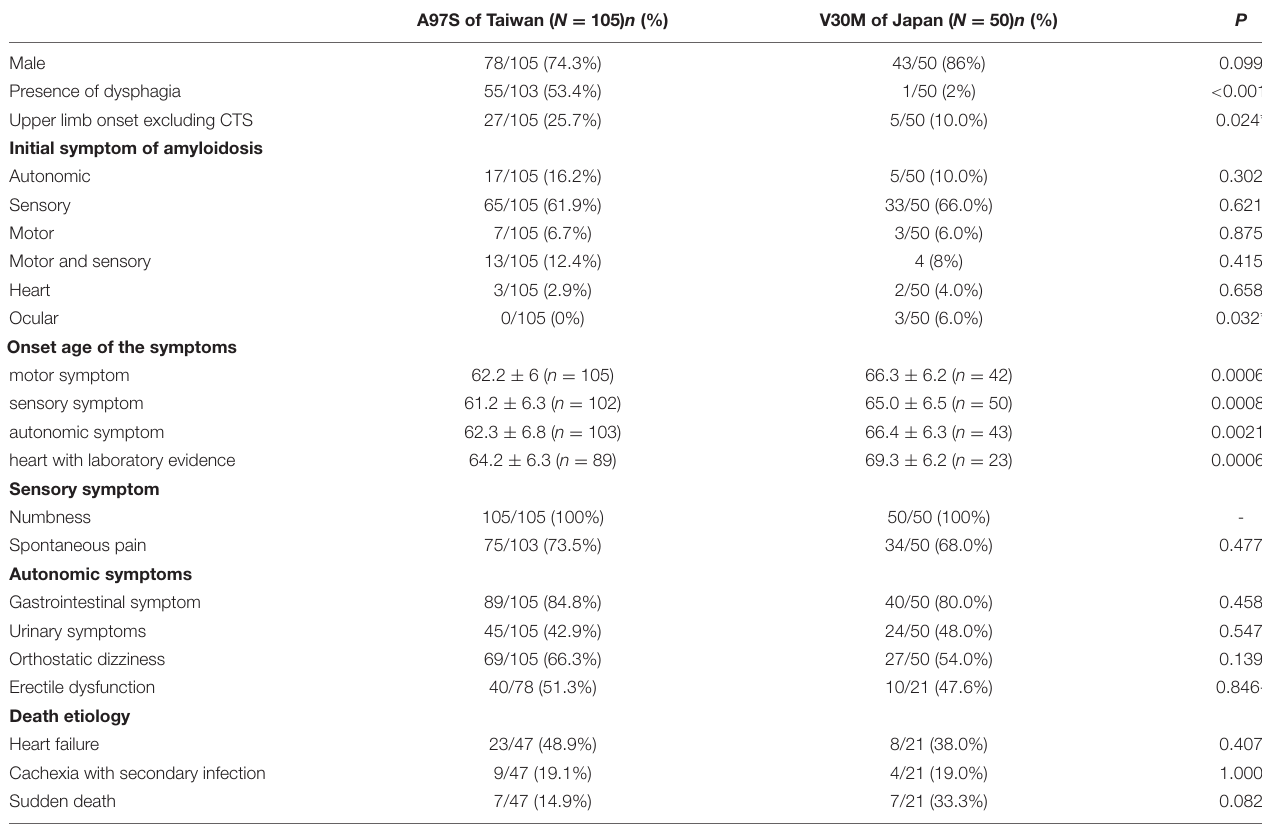
TABLE 1 | Clinical profiles in hereditary transthyretin